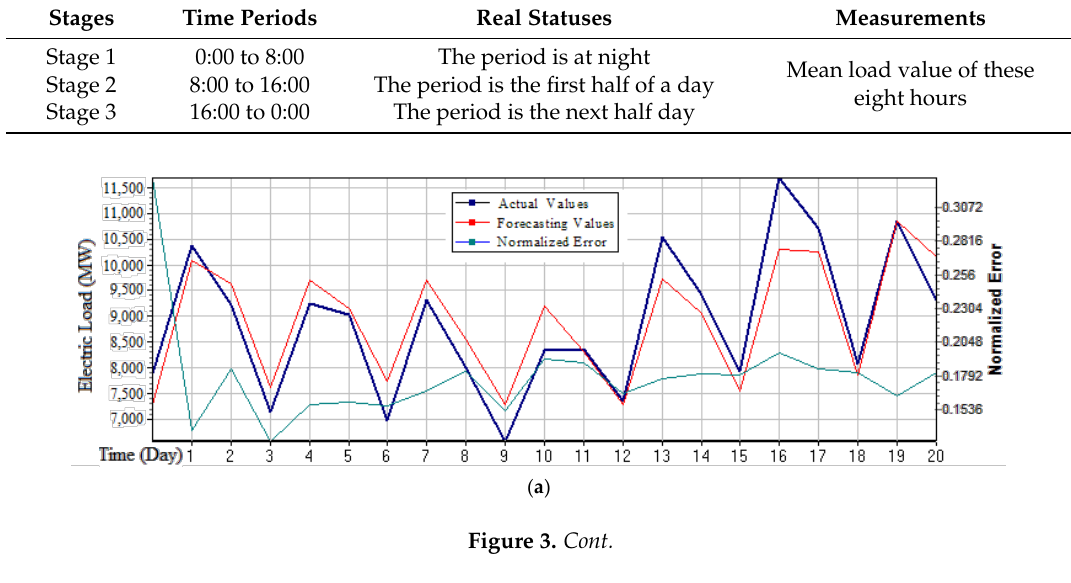
Table 3. The eight-hour scale for three stages in a day.